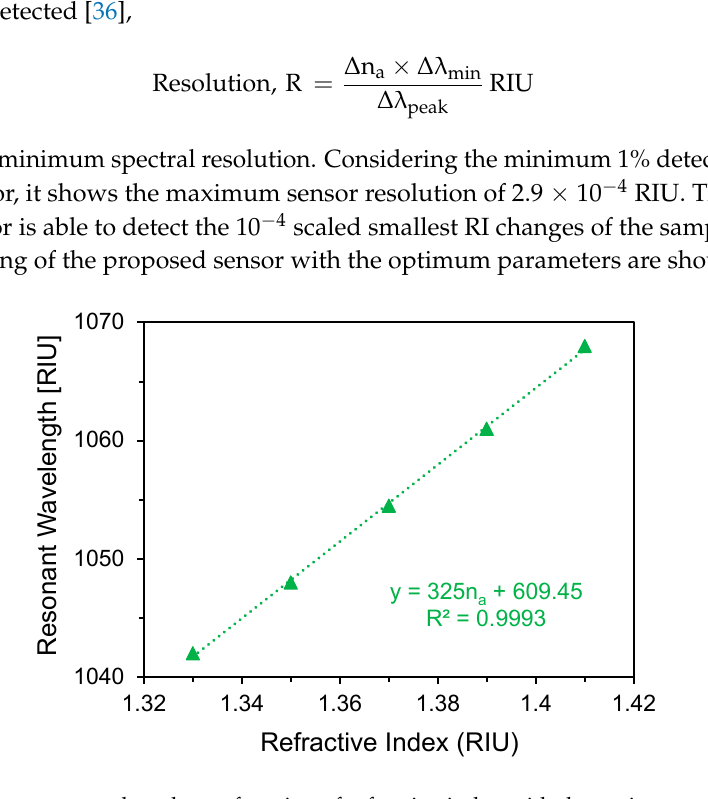
Figure 8. Resonant wavelength as a function of refractive index with the optimum parameters.